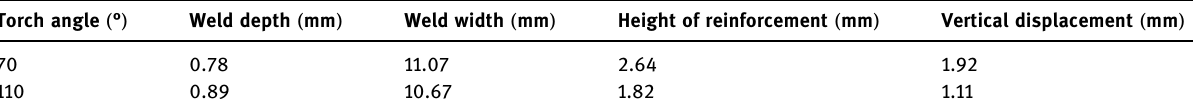
Table 3: Weld bead geometry sizes and distortion of the welds as shown in Figure 6 Torch angle ( ° )